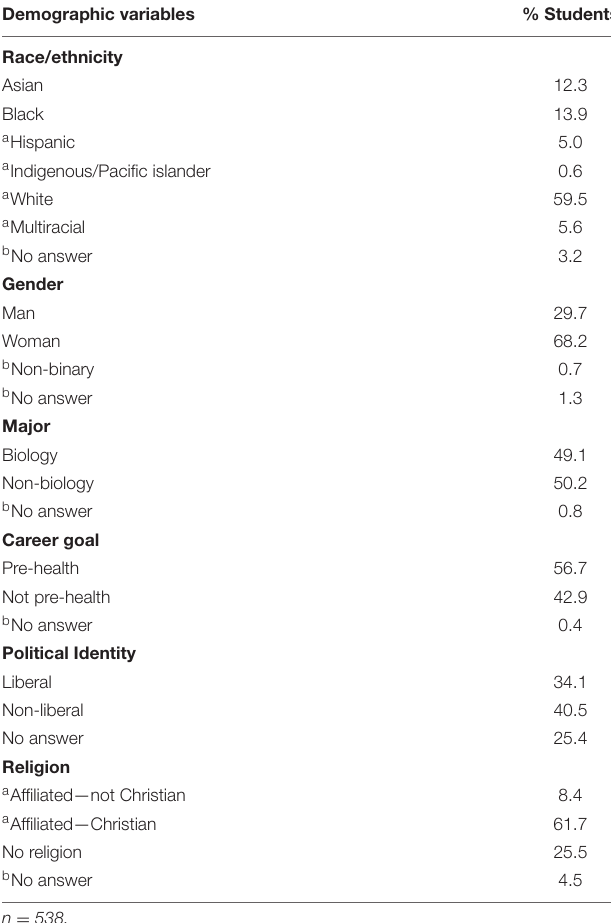
TABLE 1 | Demographics of study participants from a research-intensive university in the Southeast. Demographic